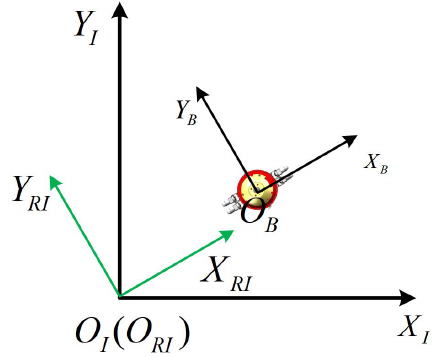
Figure 9. Diagram of the rotation inertial